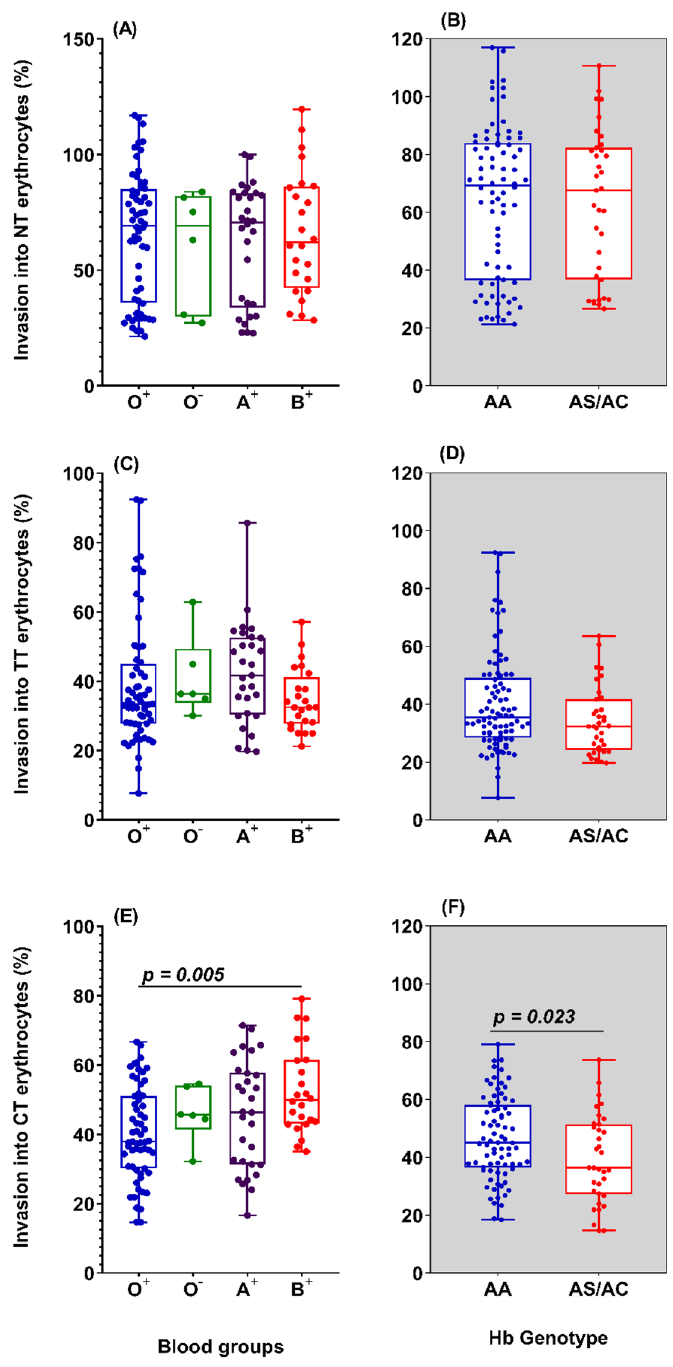
Figure 7. Relationship between blood group or haemoglobin genotype and invasion into enzyme-treated erythrocytes. Erythrocytes from donors of different blood groups (Left panel; O + = 10, O − = 1, A + = 5 and B + = 4) or haemoglobin genotypes (Right panel; AA = 14, AS/AC = 5) were treated with either neuraminidase ( A , B ), trypsin ( C , D ) or chymotrypsin ( E , F ) and co-incubated with schizont-infected P. falciparum strains for 18–24 h. For each set of donor erythrocytes, the invasion efficiency was assessed using flow cytometry and compared to that of mock-treated control erythrocytes. The data were analysed using Graph Pad Prism v.8.01. Differences in the invasion efficiency into erythrocytes of different blood group were assessed using the Kruskal Wallis test and where significant, pairwise comparisons were performed with the Dunn’s multiple comparison test. The Mann–Whitney test was used to compute for differences in the invasion efficiency into erythrocytes harbouring different haemoglobin